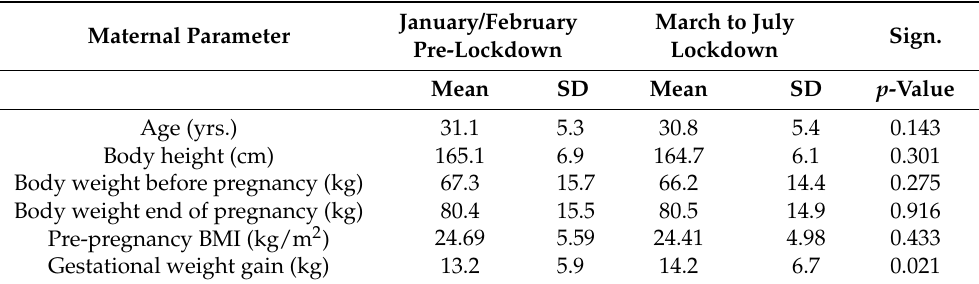
Figure 2. Prevalence of Caesarean section rate in Austria [42] and in the Danube Hospital 2005 to 2020. Table 4. Maternal somatic parameters. A comparison between pre-lockdown and lockdown months in 2020 (Student’s t